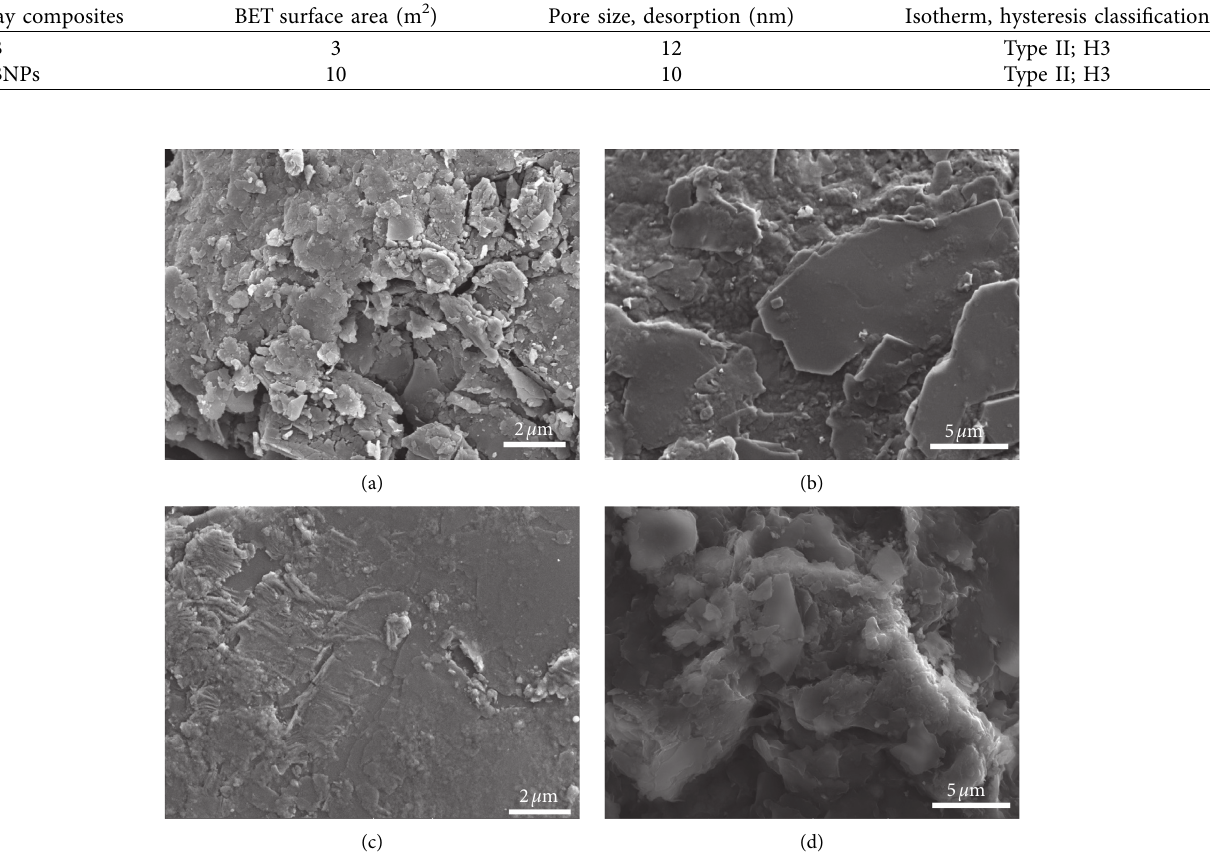
Table 1: Adsorption isotherms’ parameters and IUPAC classification for adsorbents granules.